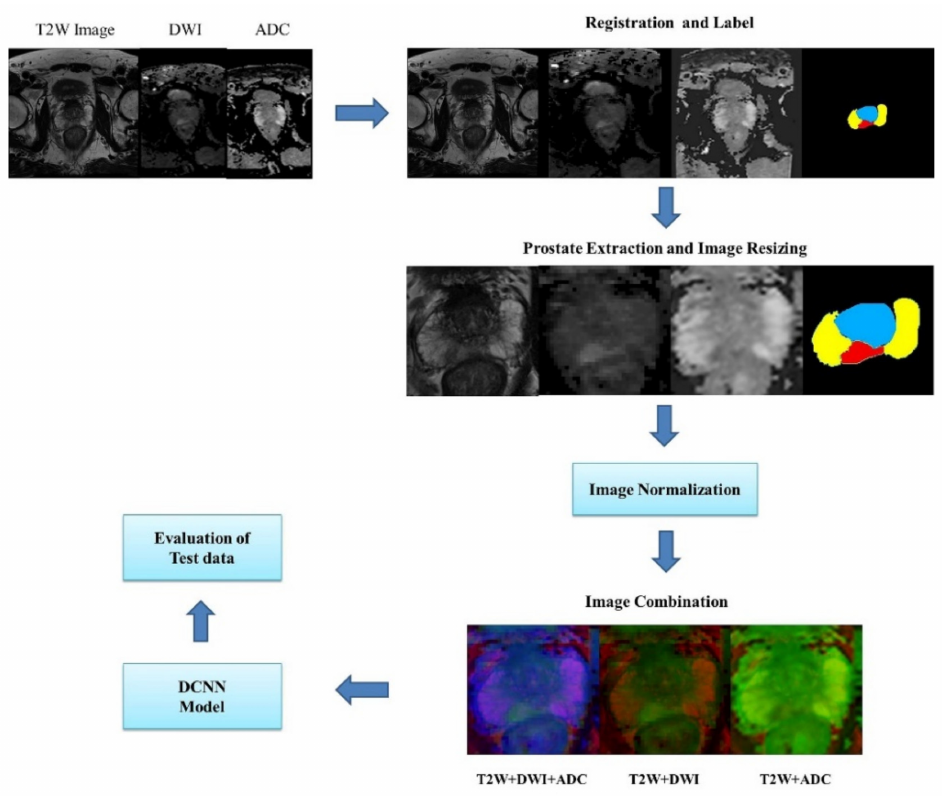
Figure 1. Method for evaluating encoder–decoder DCNN architectures in the semantic segmentation of prostate bpMRI images.